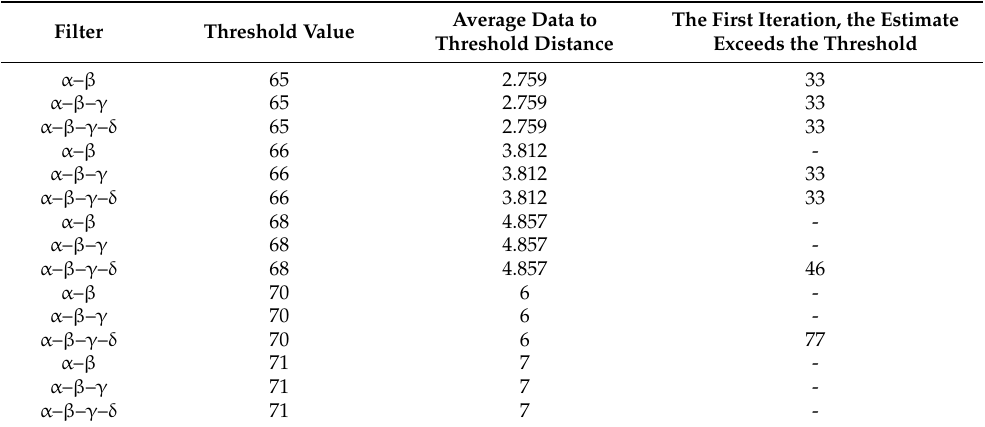
Table 3. The filter’s performance depends on the threshold value and the distance to the average data value.